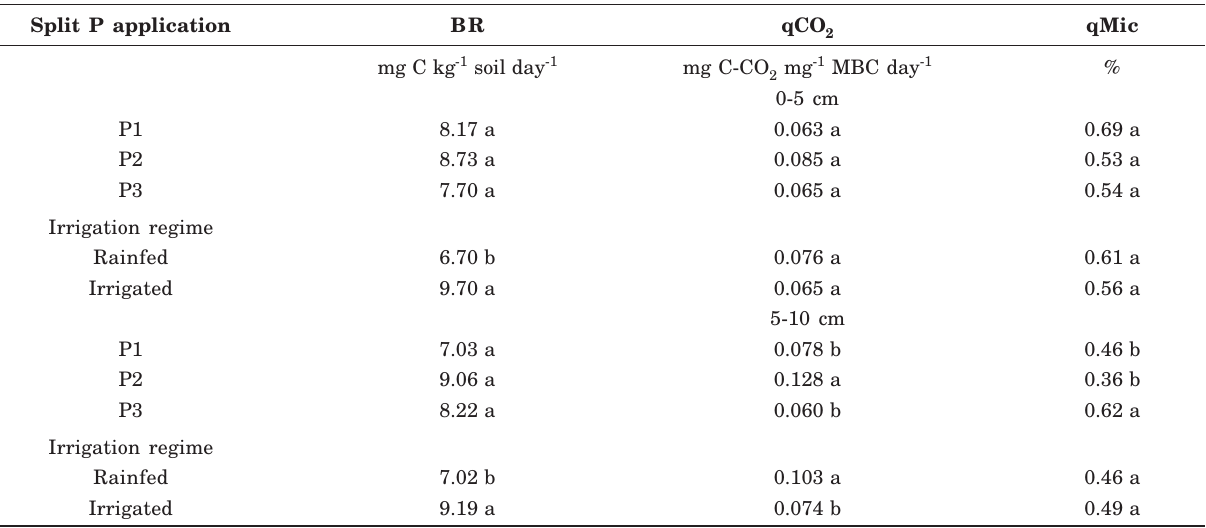
P1: 300 kg ha -1 P O , applied annually, 2/3 of the total amount in September and 1/3 in December. P2: 600 kg ha -1 P 2 5 reapplication every two years. P3: 1,800 kg ha -1 P column did not differ from each other by Tukey’s test